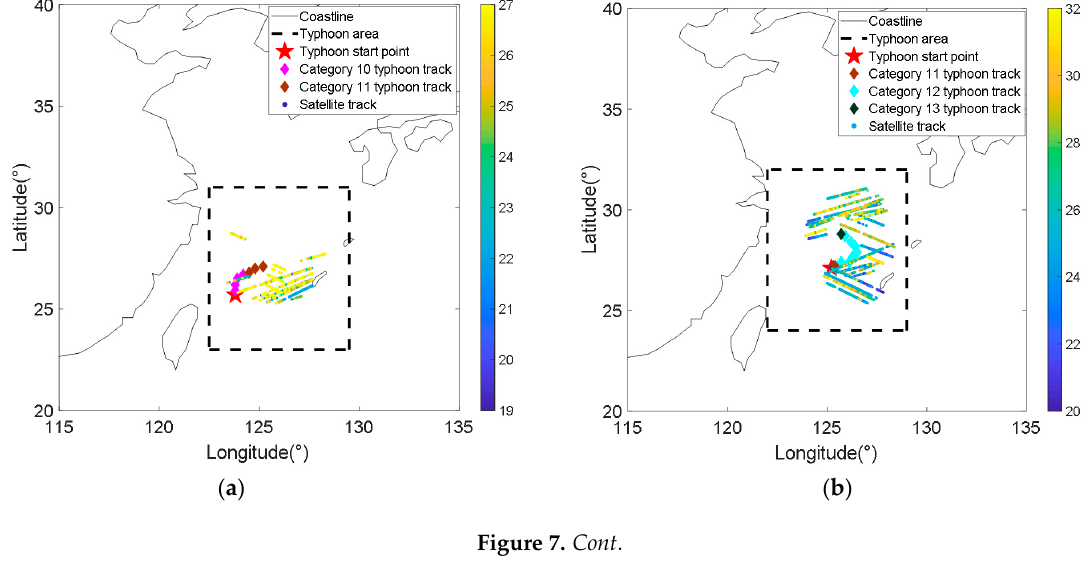
Table 4. Comparison results of wind speed data from Department of Water Resources of Zhejiang Province. Beaufort